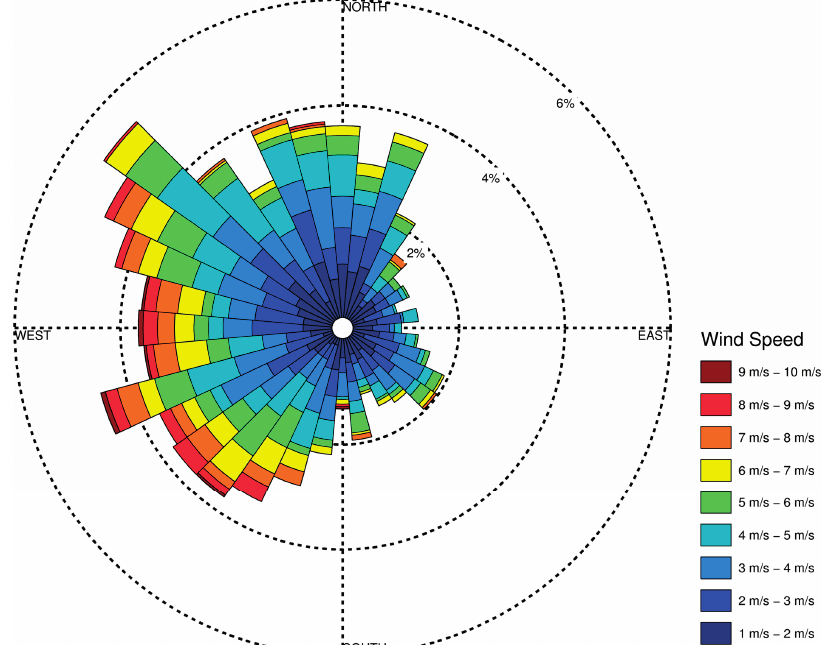
Figure 4. Wind rose for Detroit City Airport during the fall 2010 period, with wind speeds in meters per second. Paddles show the direction from which the wind is originating as it blows over the Detroit